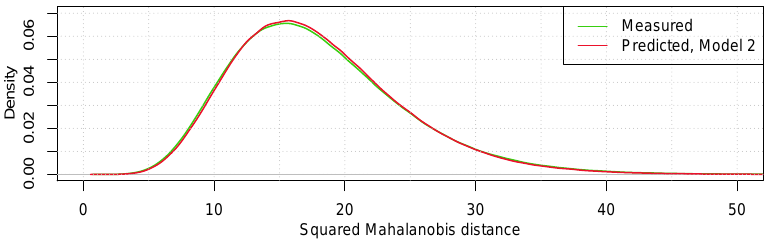
Figure 2: A density of the squared Mahalanobis distance for the joint distribution of linear correlation for 18 approximations over 9 rounds of 32-bit SmallPresent using a 40-bit key-schedule. The plot compares the density measured using the full codebook to a prediction made using Model